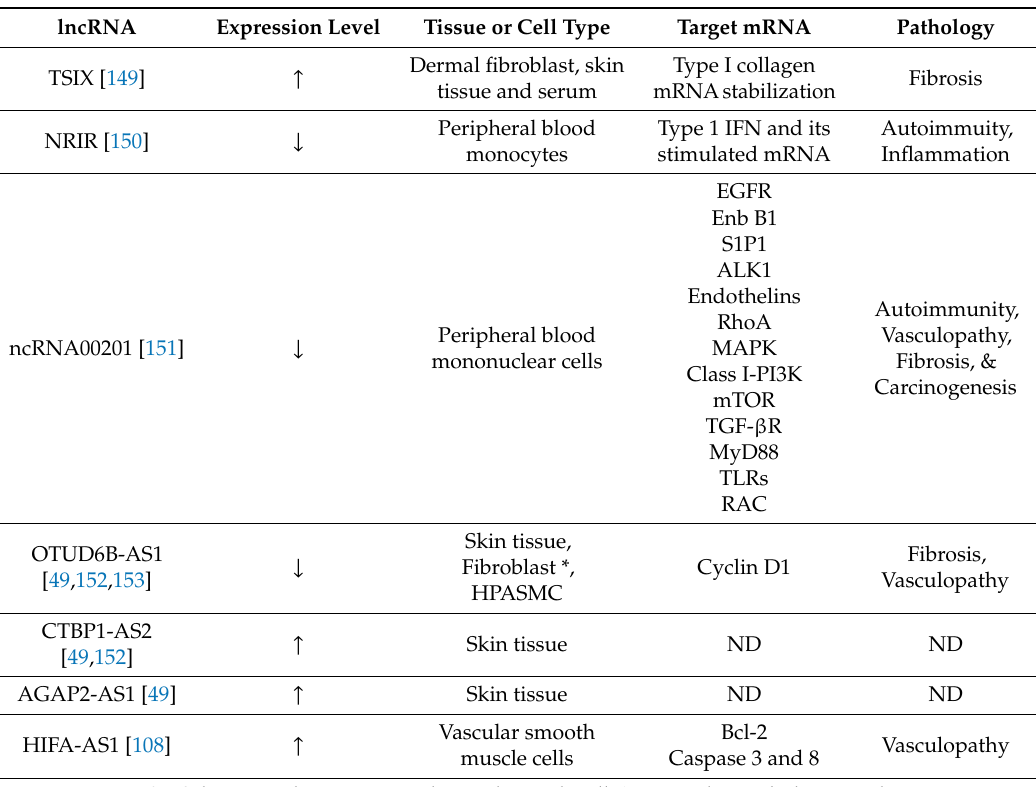
Table 3. Involvement of aberrant lncRNA expression, the target mRNA, and pathological changes in patients with systemic